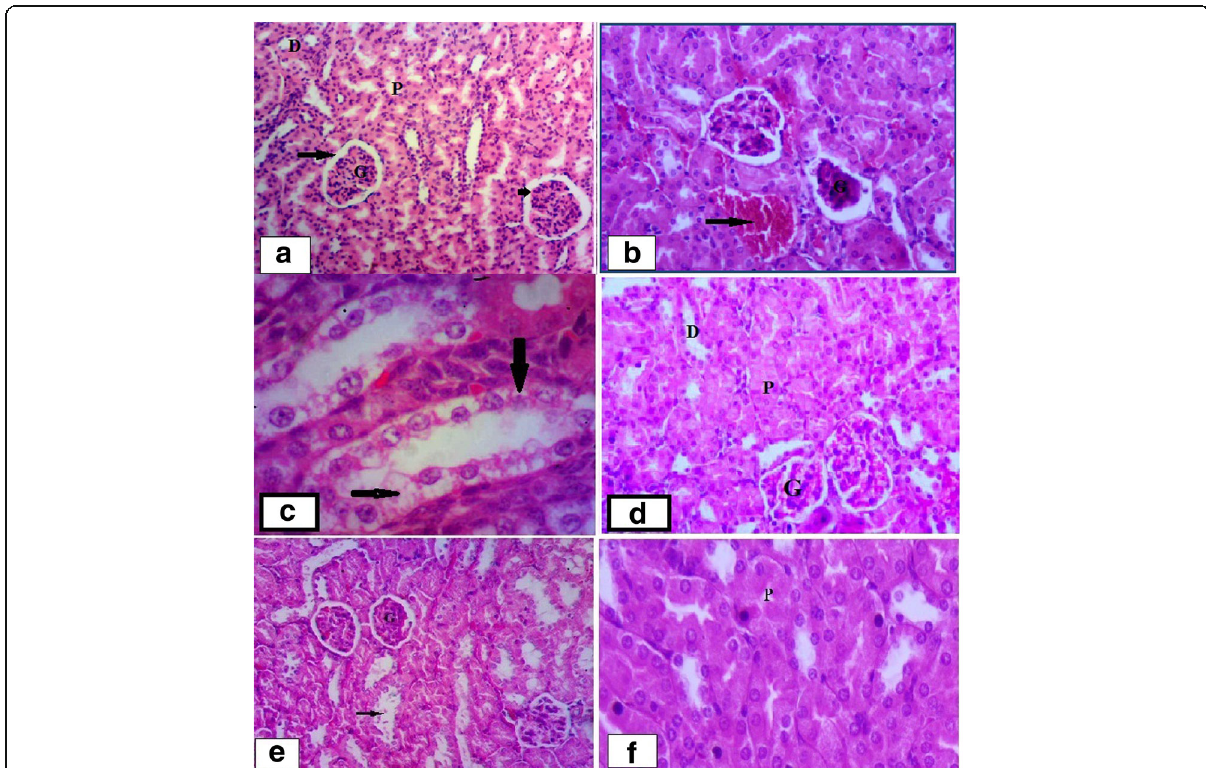
Fig. 6 Photomicrographs from the kidney tissues collected from mice of control and treated groups stained with H&E stain. The kidney of control group (GI) showing kidney cortex with Malpighian corpuscle where the parietal layer of Bowman ’ s capsule (arrow) and the glomerulus (G) is formed of lobulated tuft of capillaries being separated from the capsule by Bowman ’ s space (short arrow). Normal proximal (P) and distal tubules (D) are also seen ( a ) (×10). The renal tissue of diabetic group (GII) ( b , c ) showing highly shrinked glomeruli (G) with wide renal space and dilatation in the blood vessels with erythrocytic congestion (arrow) ( b ) (×10). c High magnification (×40) showed renal tubules with necrotic nuclei (arrows). Section of the kidney of (GIII) showing normal architecture ( d ). e , f GIV showing obvious return to nearly normal renal appearance with nearly normal glomeruli (G) and renal tubules